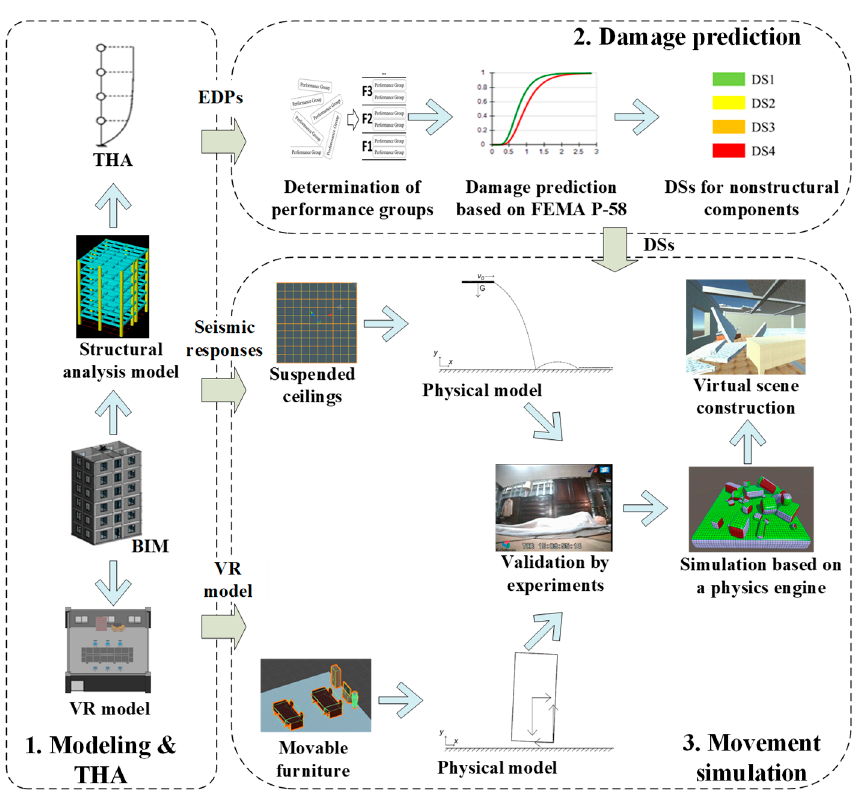
Figure 1. Framework of this study.